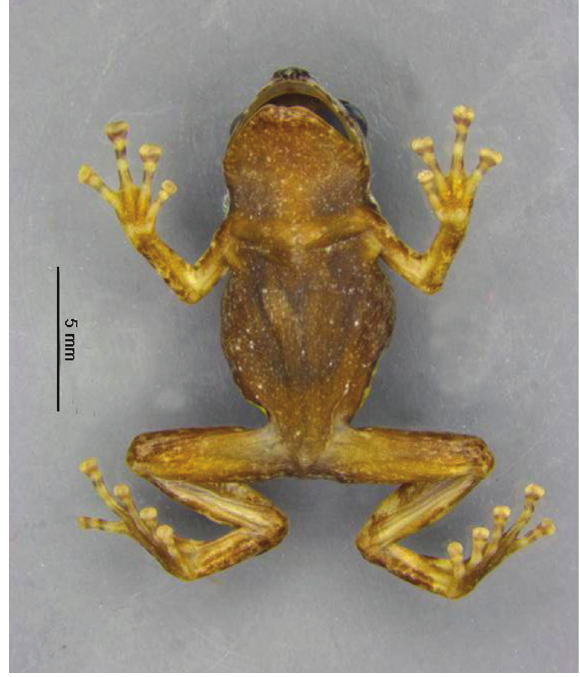
Figure 1a. Preserved holotype of Choerophryne crucifer sp. n. in dorsal view.